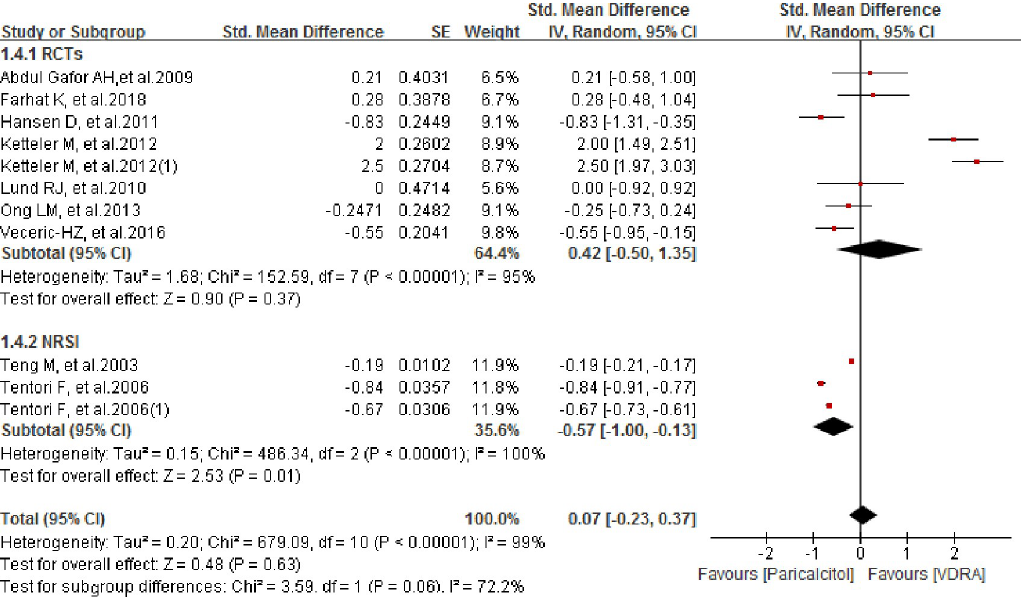
Fig 7. Forest plot of comparison between paricalcitol and VDRA regarding to serum phosphorus